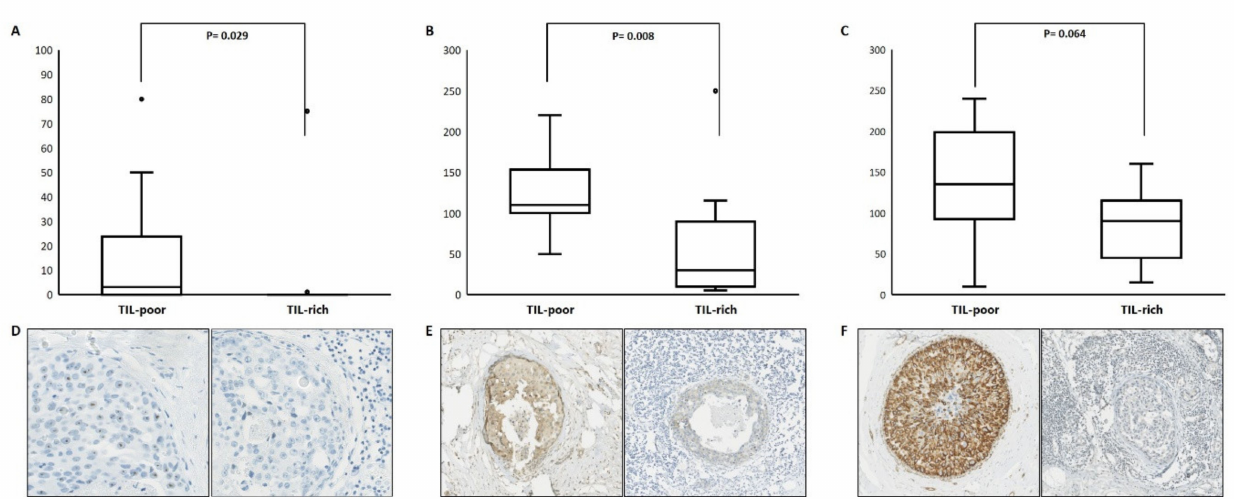
Figure 3. Protein expression of CCND3, DUSP10 and RAP1GAP according to TIL-poor and TIL-rich DCIS. The upper panels depict the protein expression level as % of CCND3 ( A ), H-scores of DUSP10 ( B ) and RAP1GAP ( C ). The lower panels depict representative immunohistochemical images of CCND3 ( D ) at 40 × , DUSP10 ( E ) and RAP1GAP ( F ) at 10 ×